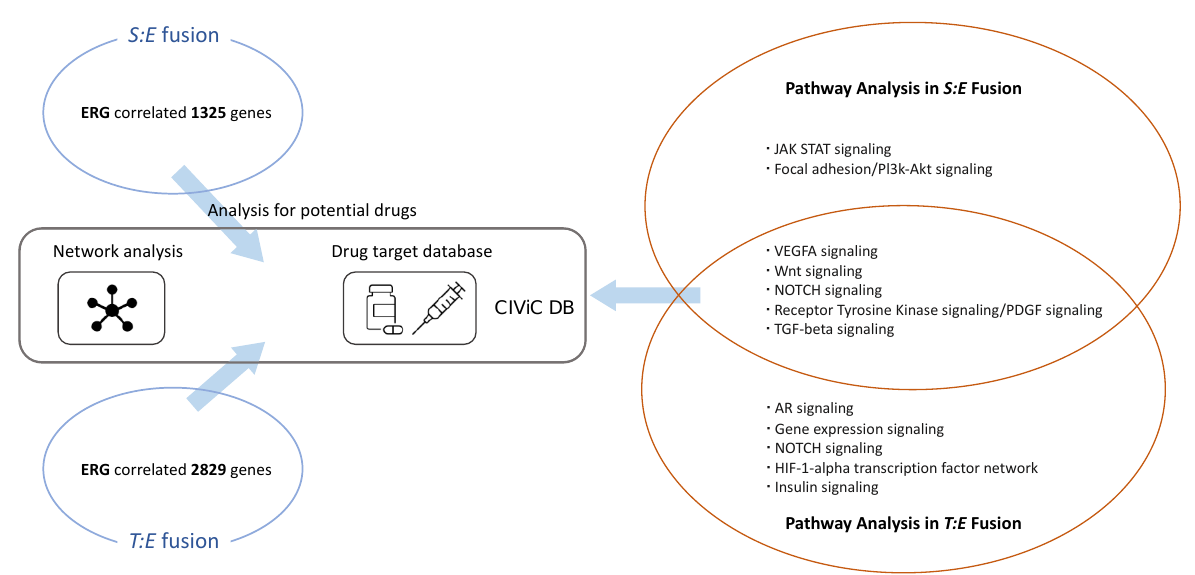
Figure 1. An overview of the analyses in this study. In total, 1325 genes were selected through a Pearson correlation test of S:E fusion-positive prostate cancer compared with ERG fusion-negative prostate cancer, and 2829 genes were selected through a Pearson correlation test of T:E fusion-positive prostate cancer compared with ERG fusion-negative prostate cancer. The selected genes were used for pathway analysis using ORA via CPDB, and for gene – drug network analysis via Cytoscape.